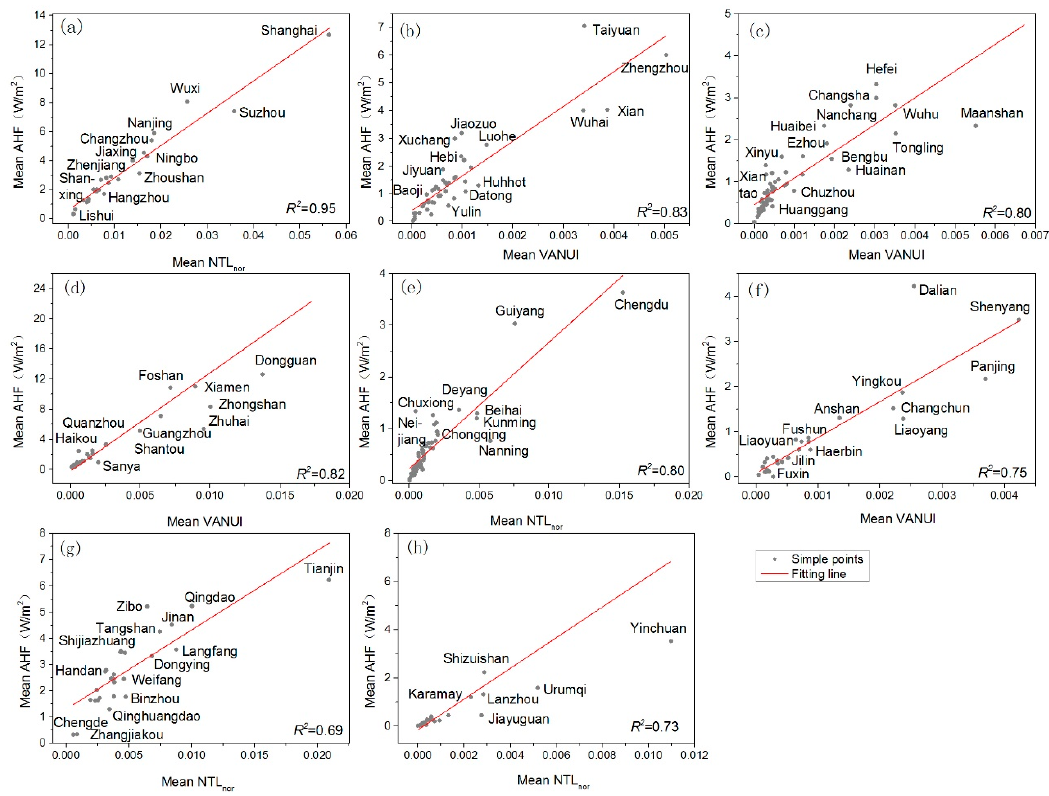
Figure 4. Linear regression relationship between AHF and vegetation adjusted nighttime light urban index (VANUI or NTLnor) in sub-regions. ( a ) ECR; ( b ) MYER; ( c ) MYAR; ( d ) SCR; ( e ) SWR; ( f ) NER; ( g ) NCR; ( h ) NWR.